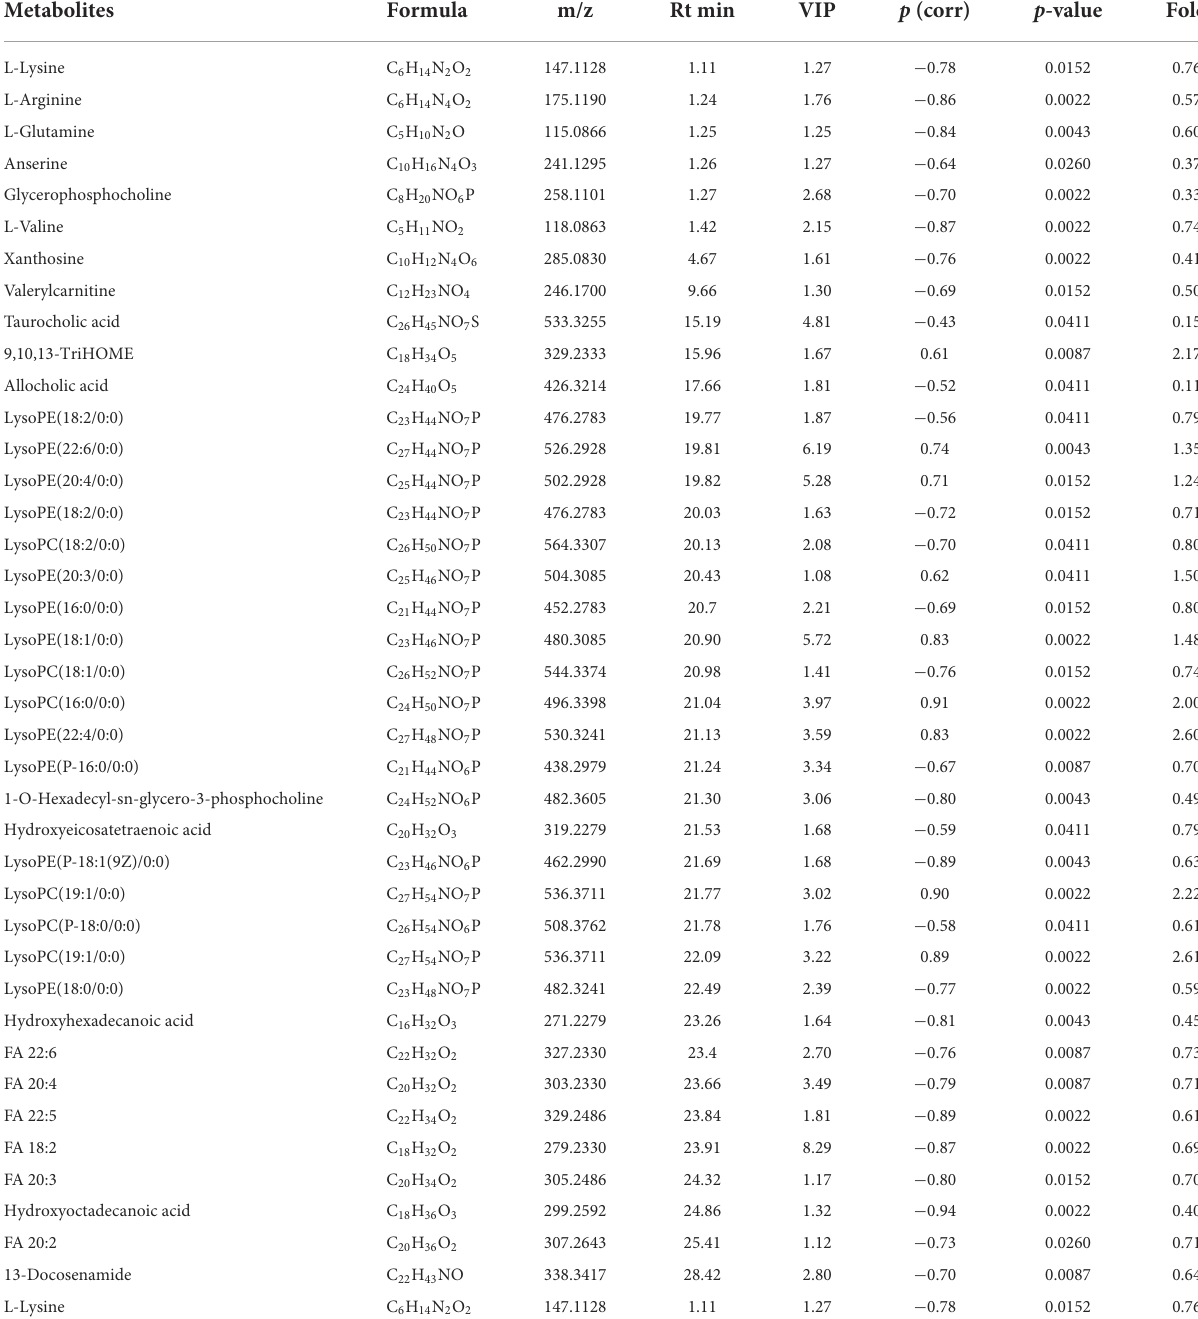
TABLE 2 Basic information of differential metabolites in Control vs.